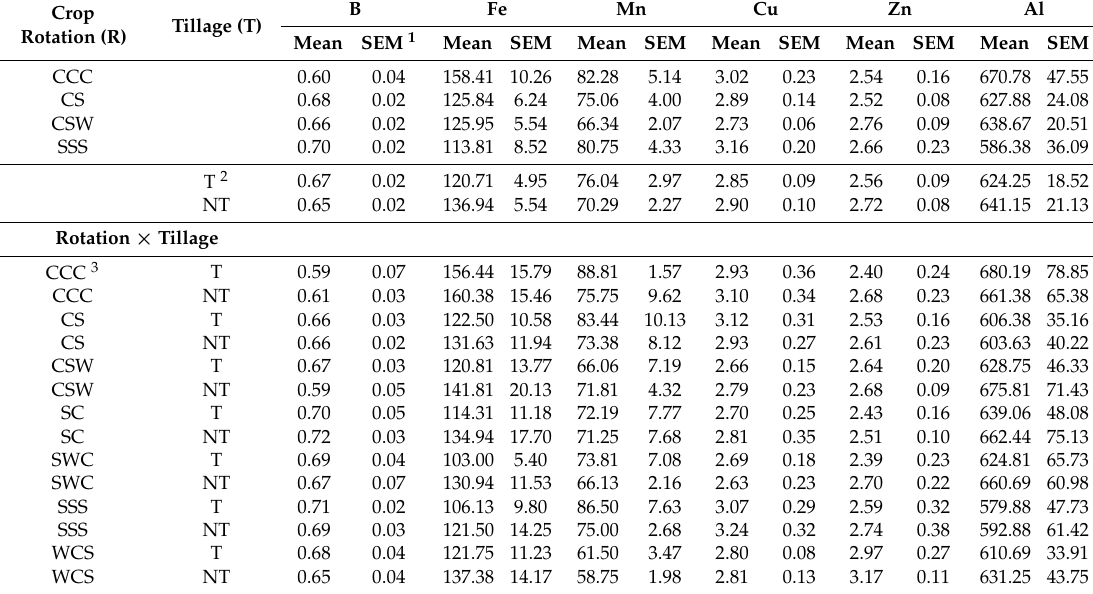
Table A8. Mean values of boron (B, mg kg − 1 ), iron (Fe, mg kg − 1 ), manganese (Mn, mg kg − 1 ), copper (Cu, mg kg − 1 ), zinc (Zn, mg kg − 1 ), and aluminum (Al, mg kg − 1 ), determined by crop rotation (R) and tillage (T) and for each R and T